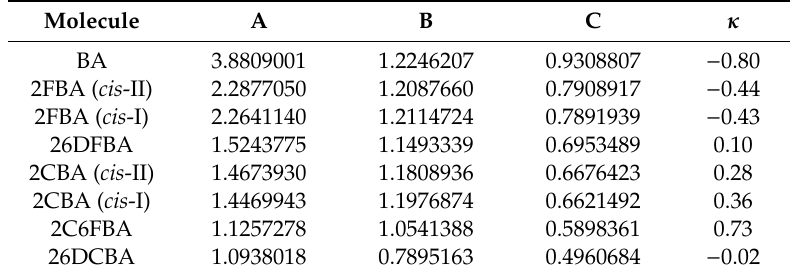
Table 1. Calculated rotational constants (GHz) and Ray’s parameter for the experimentally relevant conformers of the studied molecules. Molecule A B C κ